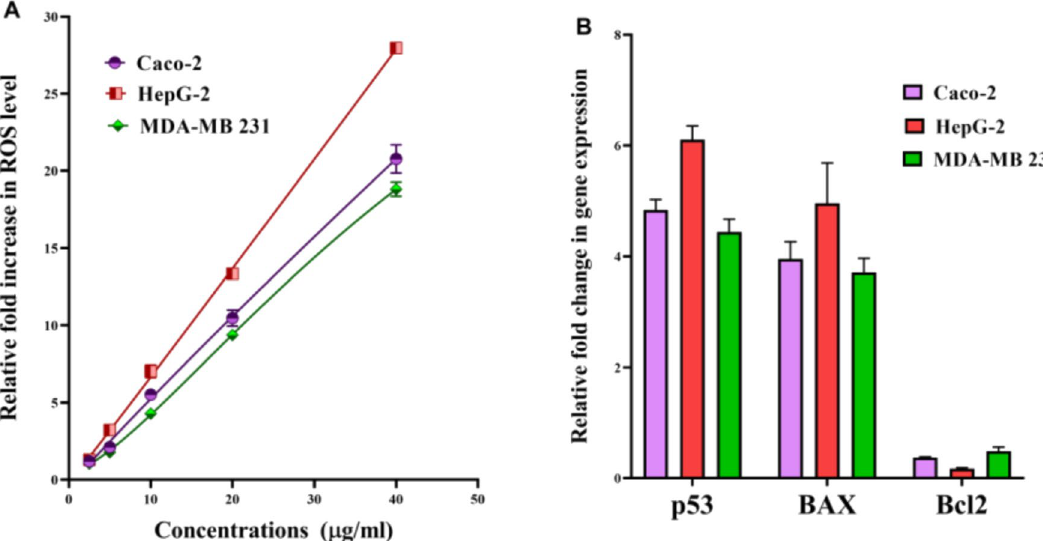
Figure 4. Prooxidant effect-mediated apoptotic activity of Au NPs human cancer cell lines (Caco-2, HepG-2 and MDA-MB 231). ( A ) The relative fold increase in ROS level in human cancer cell line after 72 h incubation with serial concentrations of Au NPs. ( B ) Relative change in p53, BAX and Bcl2 expression in IC 50 of Au NPs- treated cancer cells. All data are expressed as mean ± SEM.